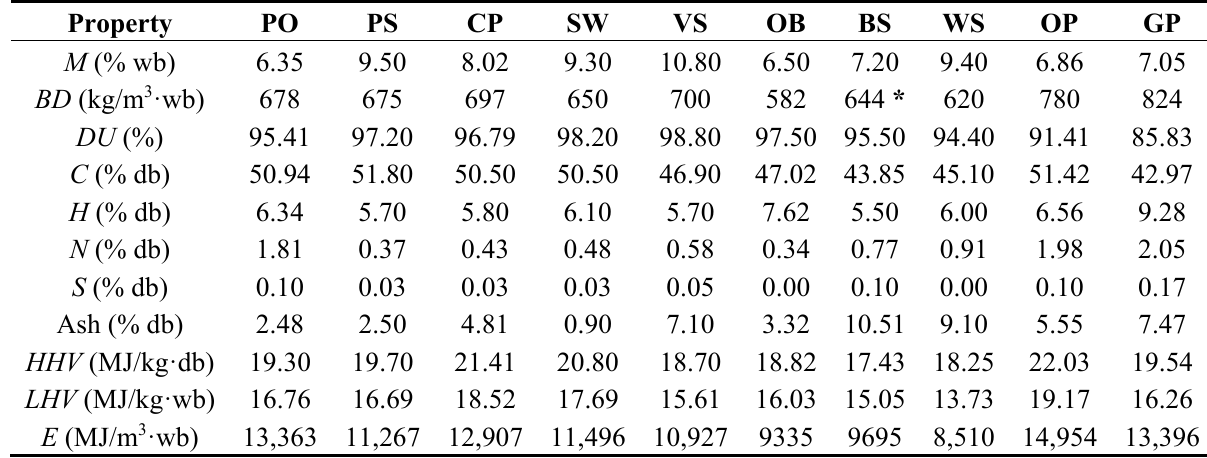
Table 4. Characteristics of the studied